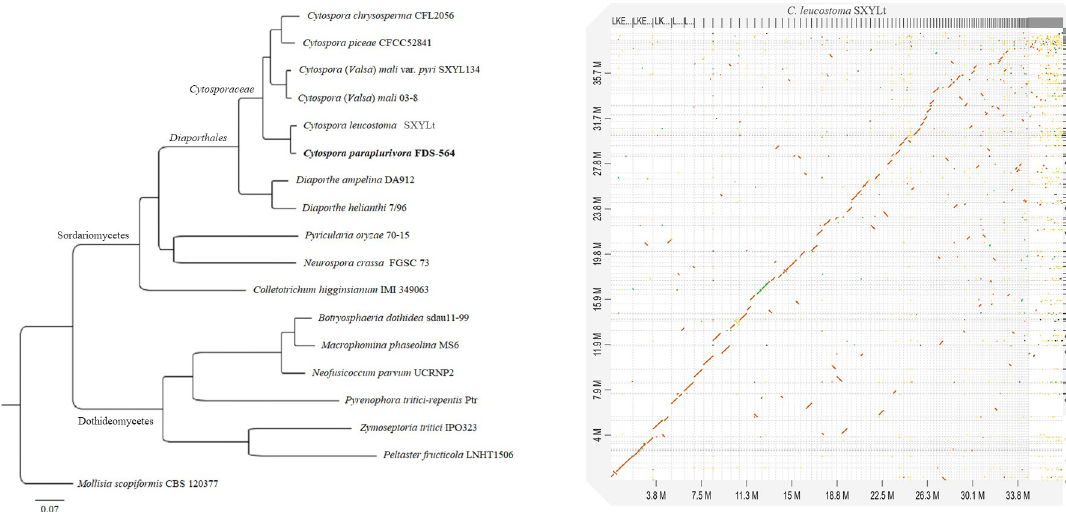
Fig 4. A. ML tree indicating the placement of C . paraplurivora FDS-564 among 17 species of Ascomycetes. Bootstrap support for all nodes is 100. B. Dot plot graph showing syntenic blocks between genome sequences of C . leucostoma SXYLt and C . paraplurivora FDS-